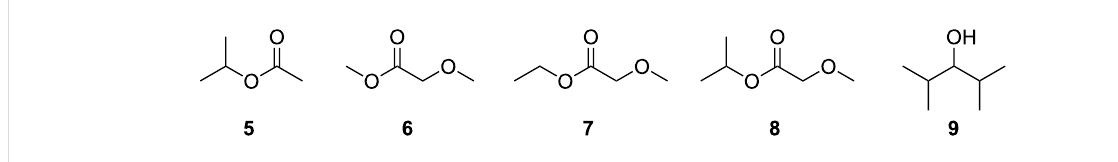
Figure 1: Acyl donors and hydrogen donor used in DKR.